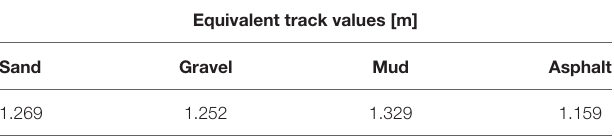
FIGURE 10 | Equivalent track values for sand, gravel, mud, and asphalt. TABLE 1 | Equivalent track values for different